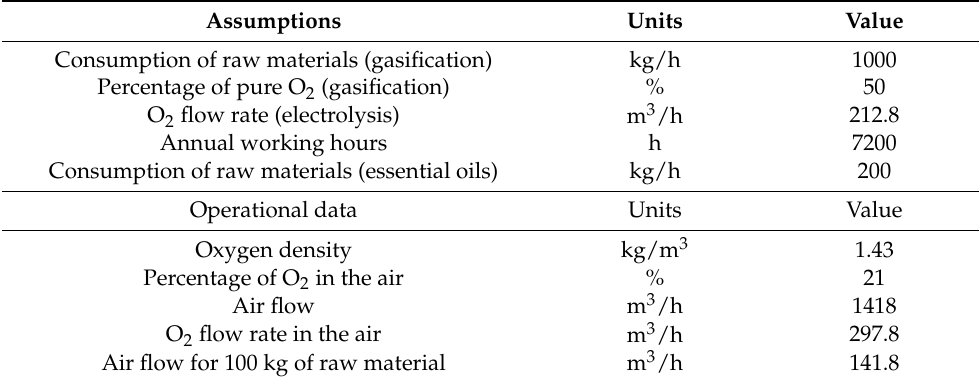
Table 1. Initial assumptions for the proposed complex multi-product biorefinery.